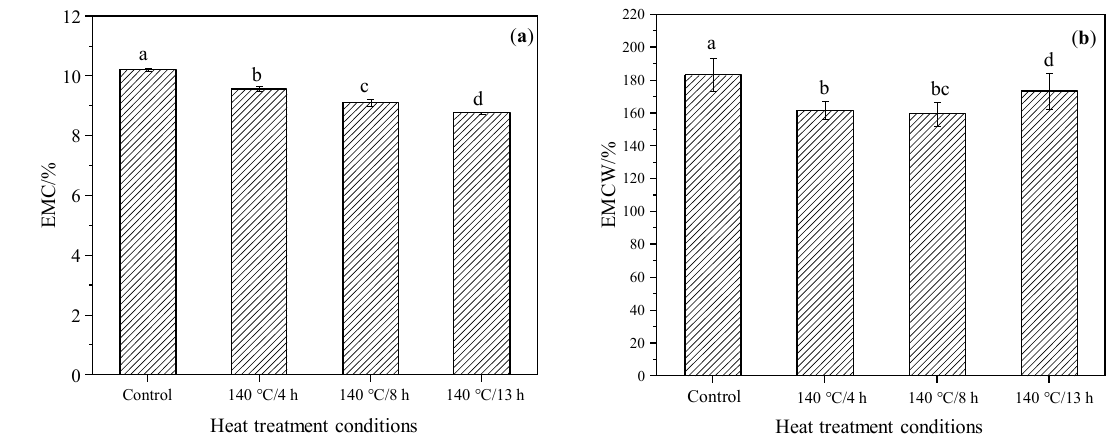
Figure 5. The EMC ( a ) and EMCW ( b ) of the control and modified wood. Bars with different letters (left: a, b, c and d, and right: a, b, bc and d) indicate significant differences ( p < 0.05) according to Duncan’s multiple range tests.